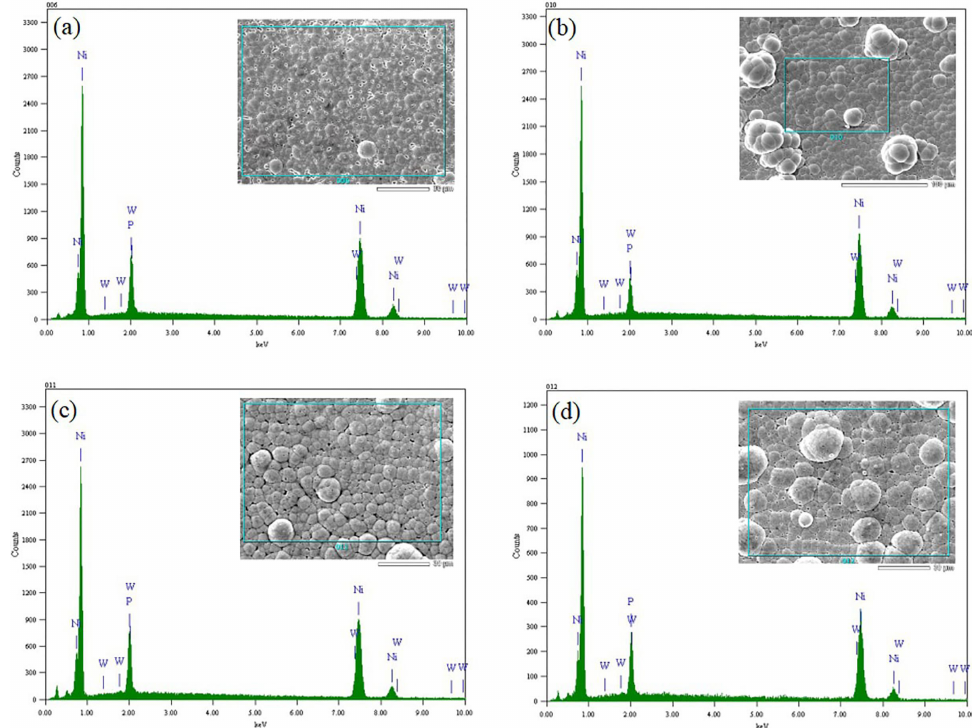
WO concentrations. (a) 5 g/L (b) 10 g/L (c) 15 g/L (d) 20 2 4